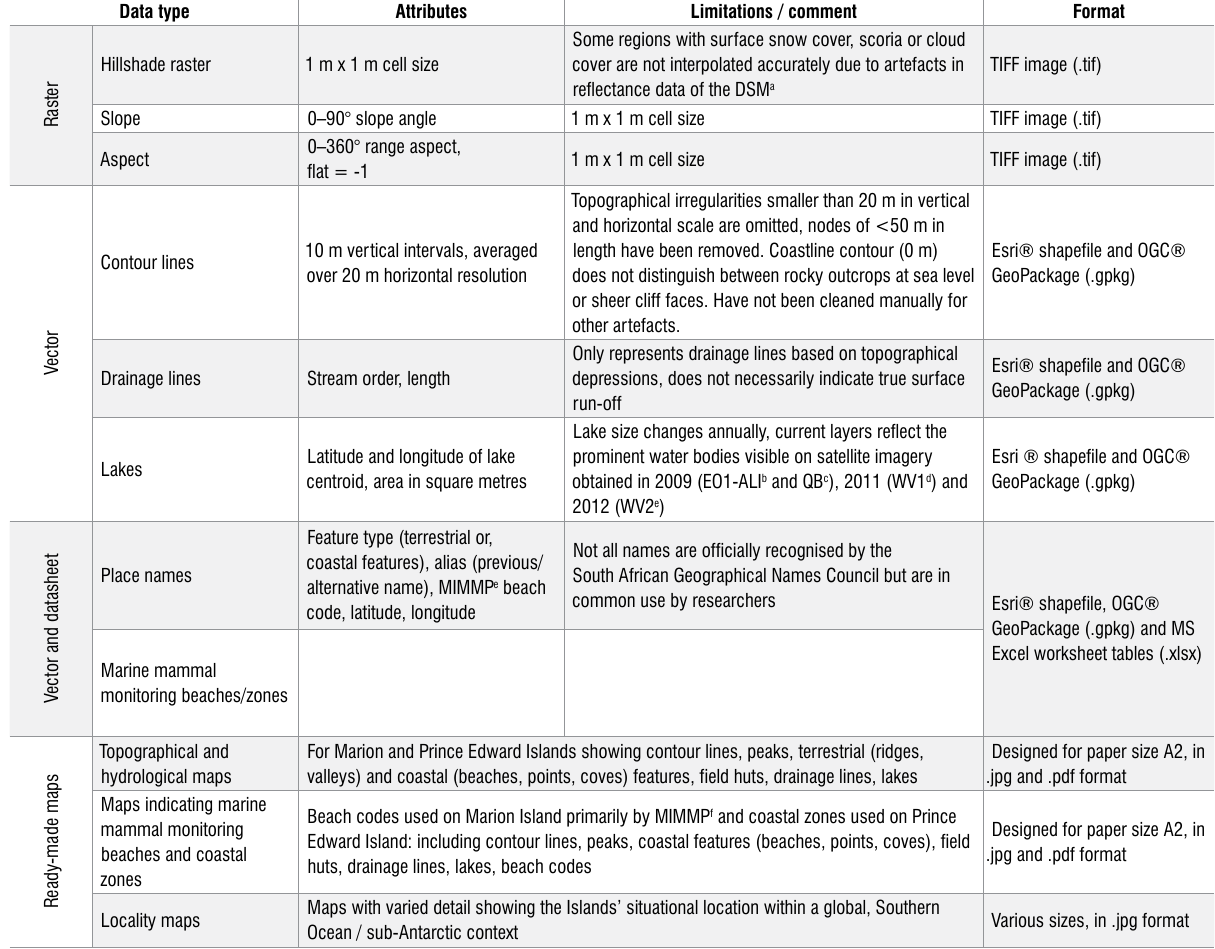
A summary of the geospatial data and downloadable maps which can be accessed through the open access dataset. The attributes and limitations of the different data layers are indicated. A list of the place names and their coordinates is included in Supplementary tables